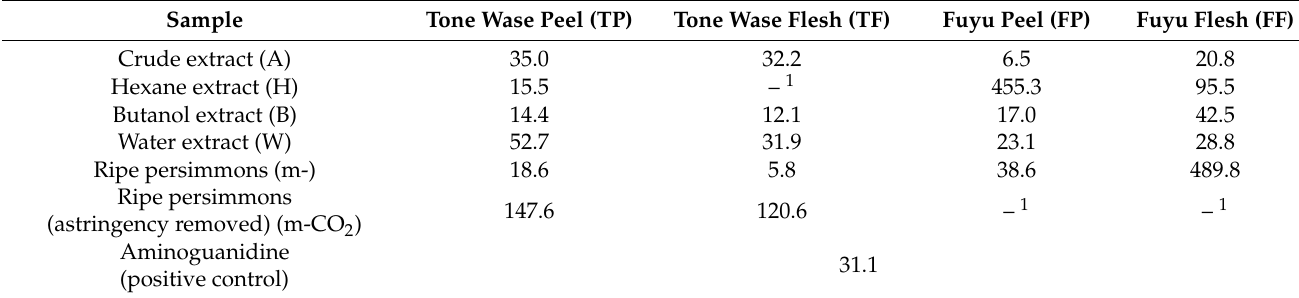
Table 3. IC 50 values of the AGE inhibitory activity test of each